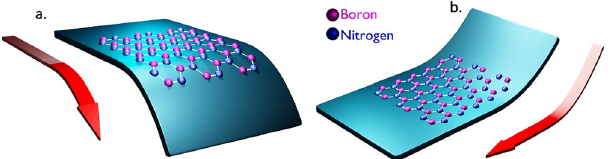
Figure 6. Schematic illustration of tensile and compressive effects. The hBN film transferred to bendable polycarbonate beam and one edge of the beam is fixed. ( a ) Another edge of PC beam is bent downwards to induce tensile strain, which leads to stretching of material towards tensile strain induced edge. ( b ) Another edge of PC is bent upwards to induce compressive strain, which leads to shrinking of material towards compressive strain induced